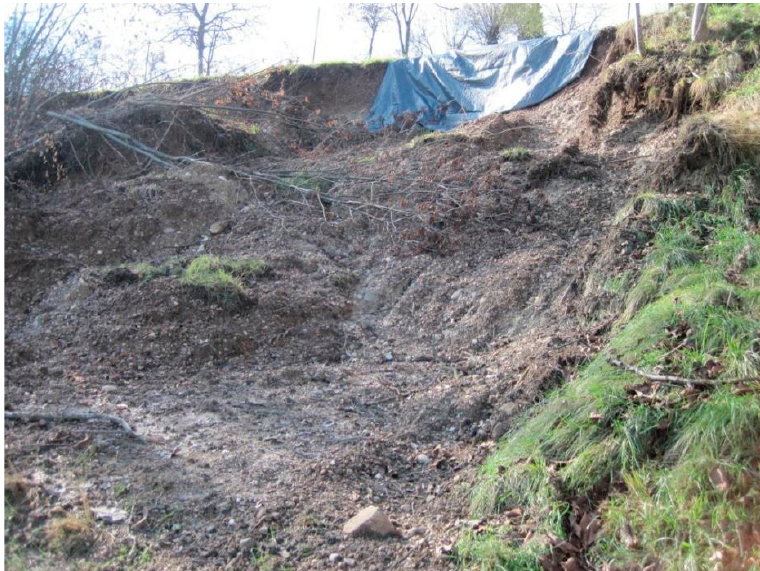
Figure 9. Landslide photograph code 025021_06c.